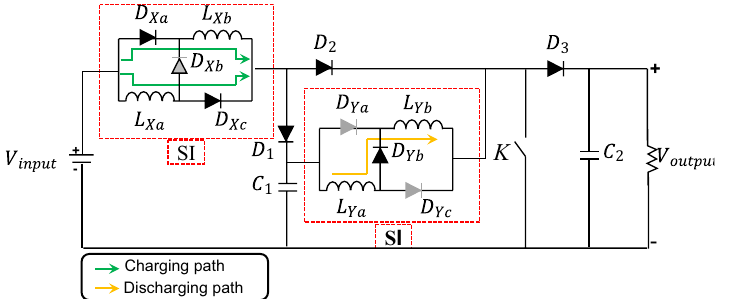
Figure 3. The structure of the